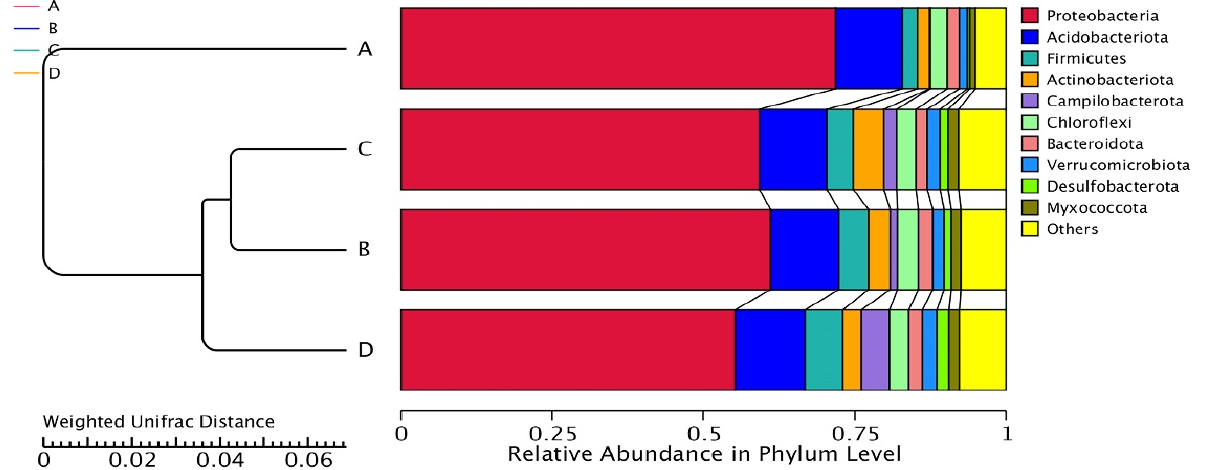
Figure 4. The UPGMA dendrogram of relative abundance at phylum level from treatments. Treatment A, an uninoculated control; B, inoculation with Paenibacillus sp. strain OL15 immobilized in agar; C, inoculation with Paenibacillus sp. strain OL15 immobilized in alginate; D, inoculation with a cell suspension of Paenibacillus sp. strain OL15.